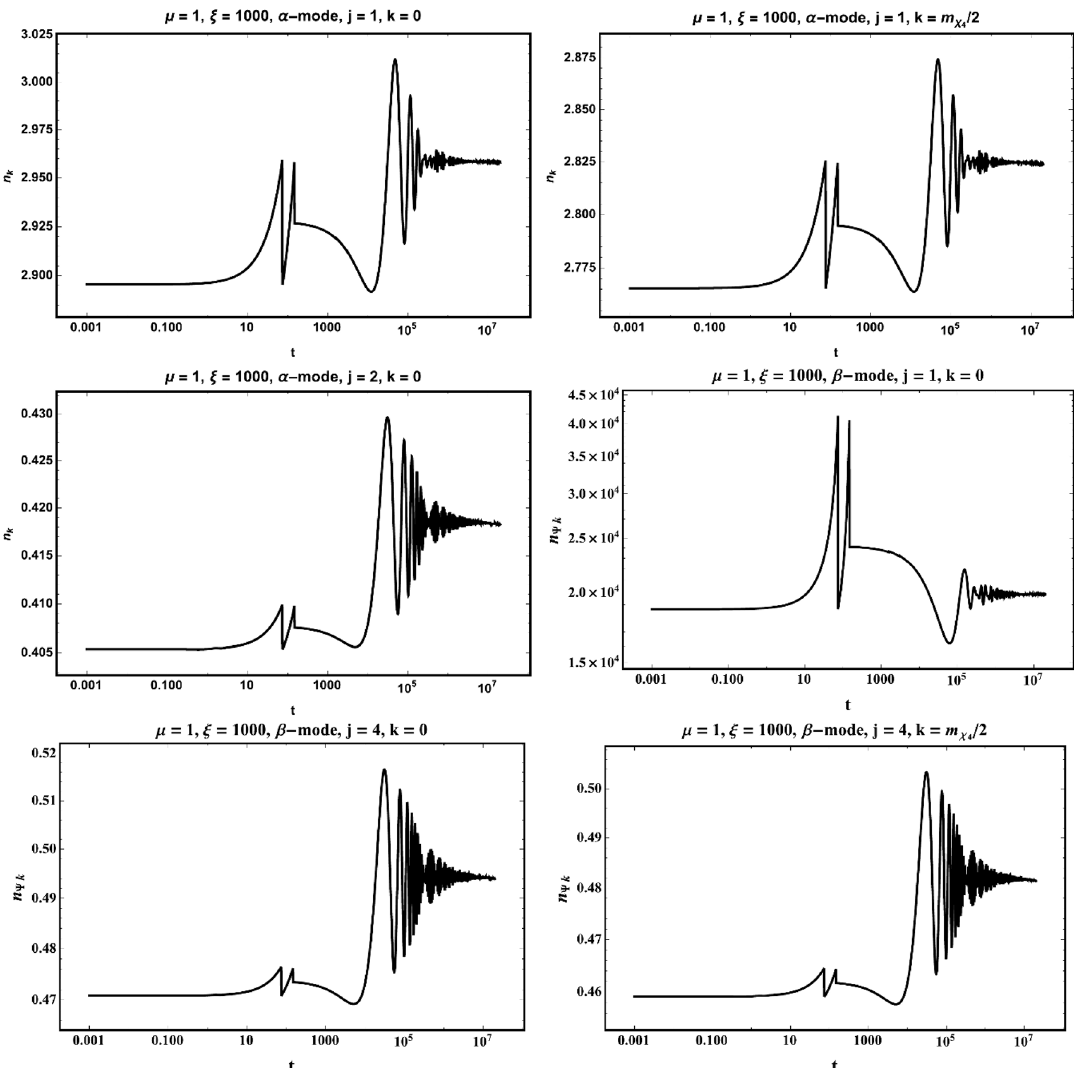
Figure 7 . The time evolution of number density of the scalar preheat (cid:12)elds (cid:9) i for (cid:22) = 1 and (cid:24) =